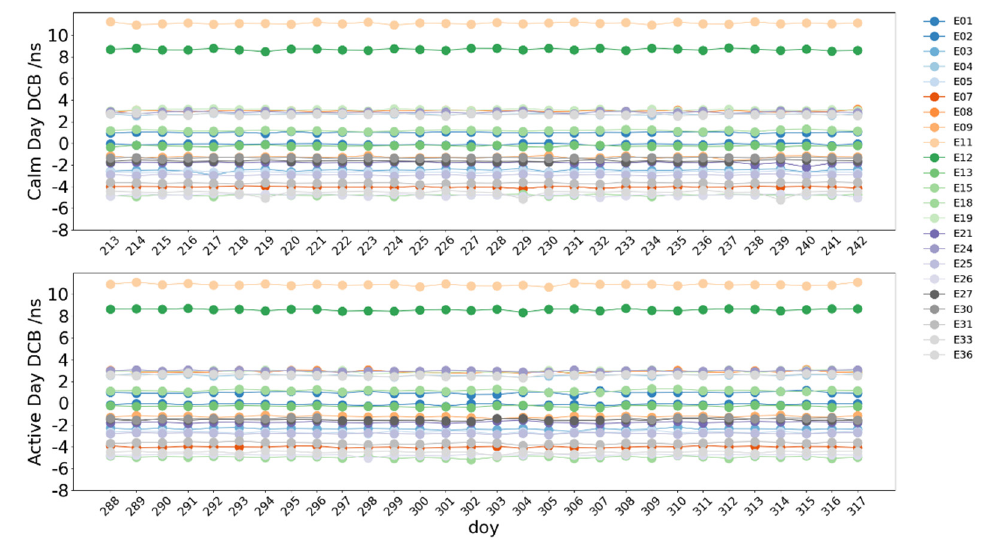
Figure 15. DCB time series of Galileo satellite at different ionospheric conditions.